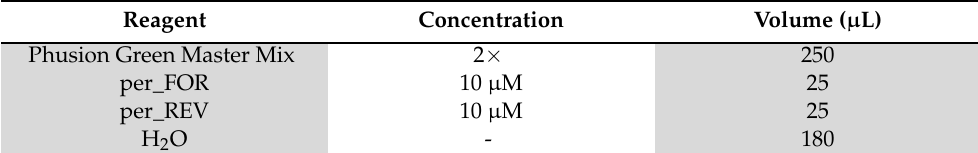
Table 2. Setup of Phusion PCR master mix.